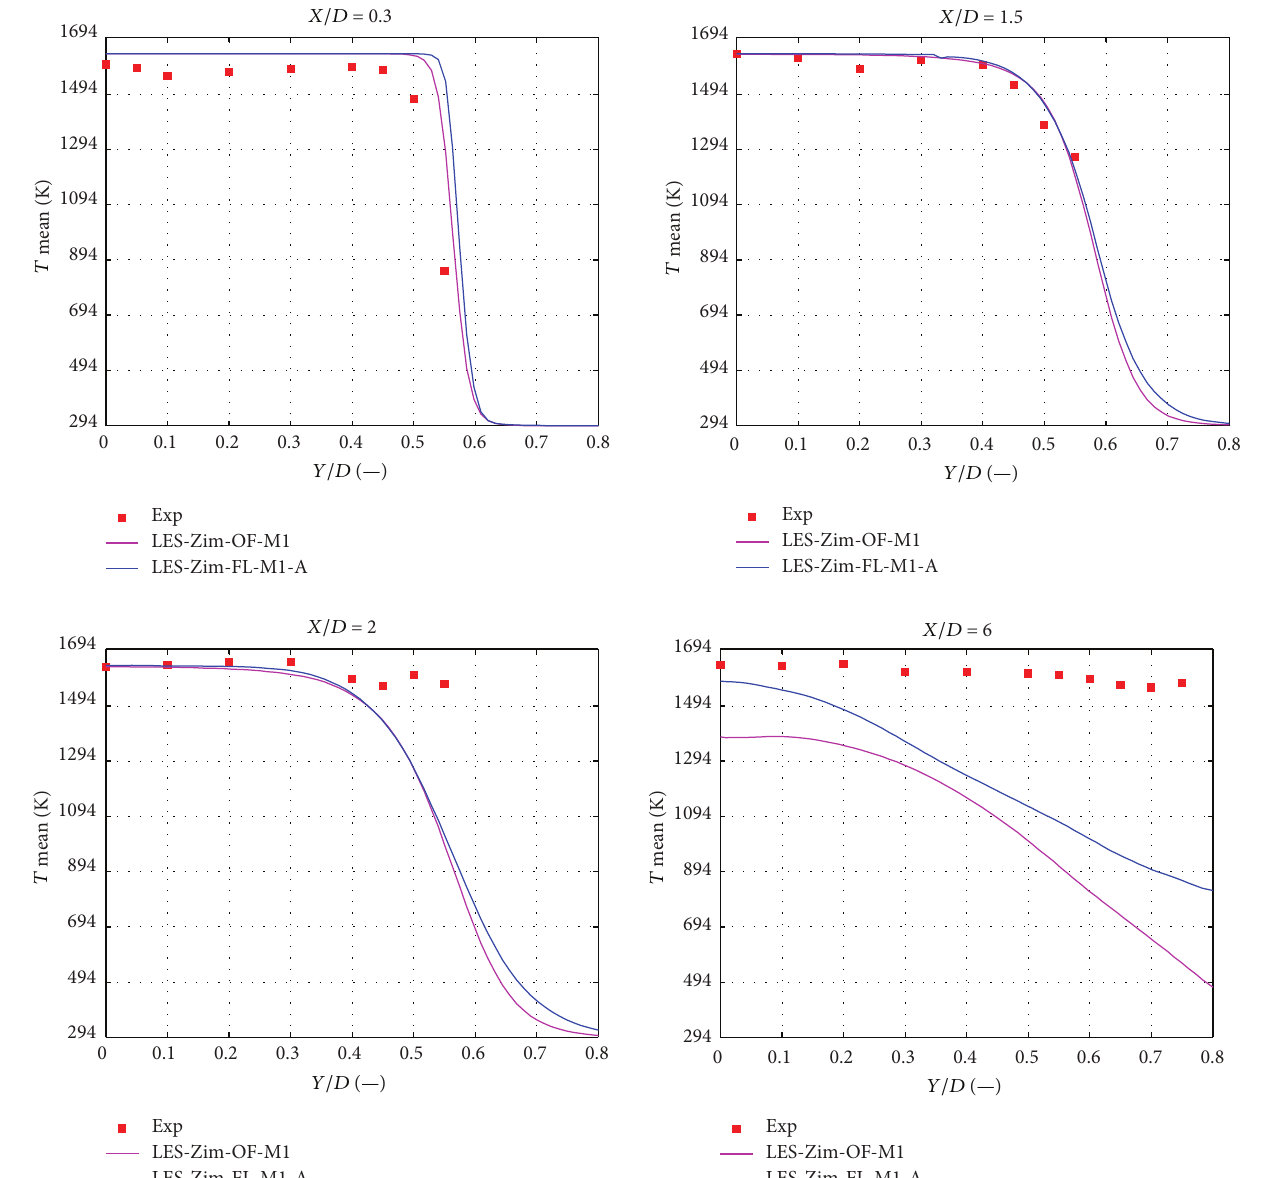
Figure 20: Temperature profiles for Fluent LES-Zim-FL-M1-A, experimental results, and LES-Zim-OF-M1.